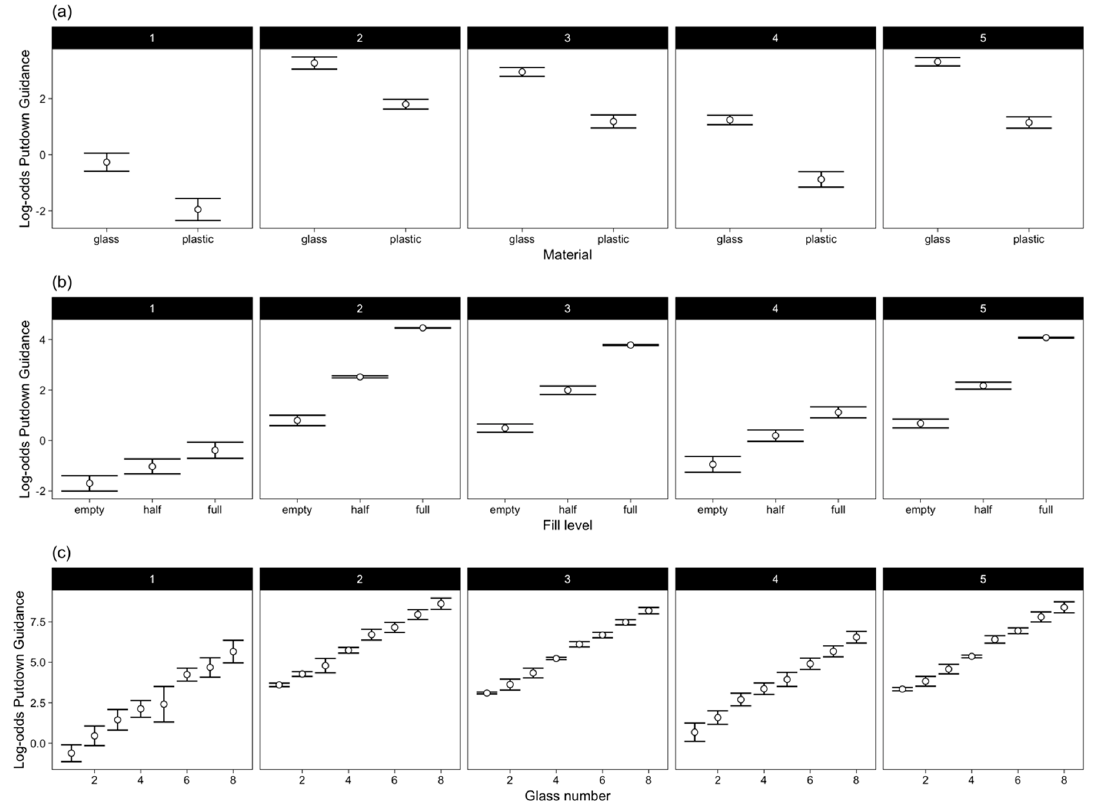
Figure 3. Log-odds plots of putdown 2 guidance with 95% CI across glass material (top row), fill level Figure A3. Log-odds plots of putdown 2 guidance with 95% CI across glass material ( a ), fill level ( b ) (middle row) and glass number (bottom row). Panels represent each participant. and glass number ( c ). Panels represent each